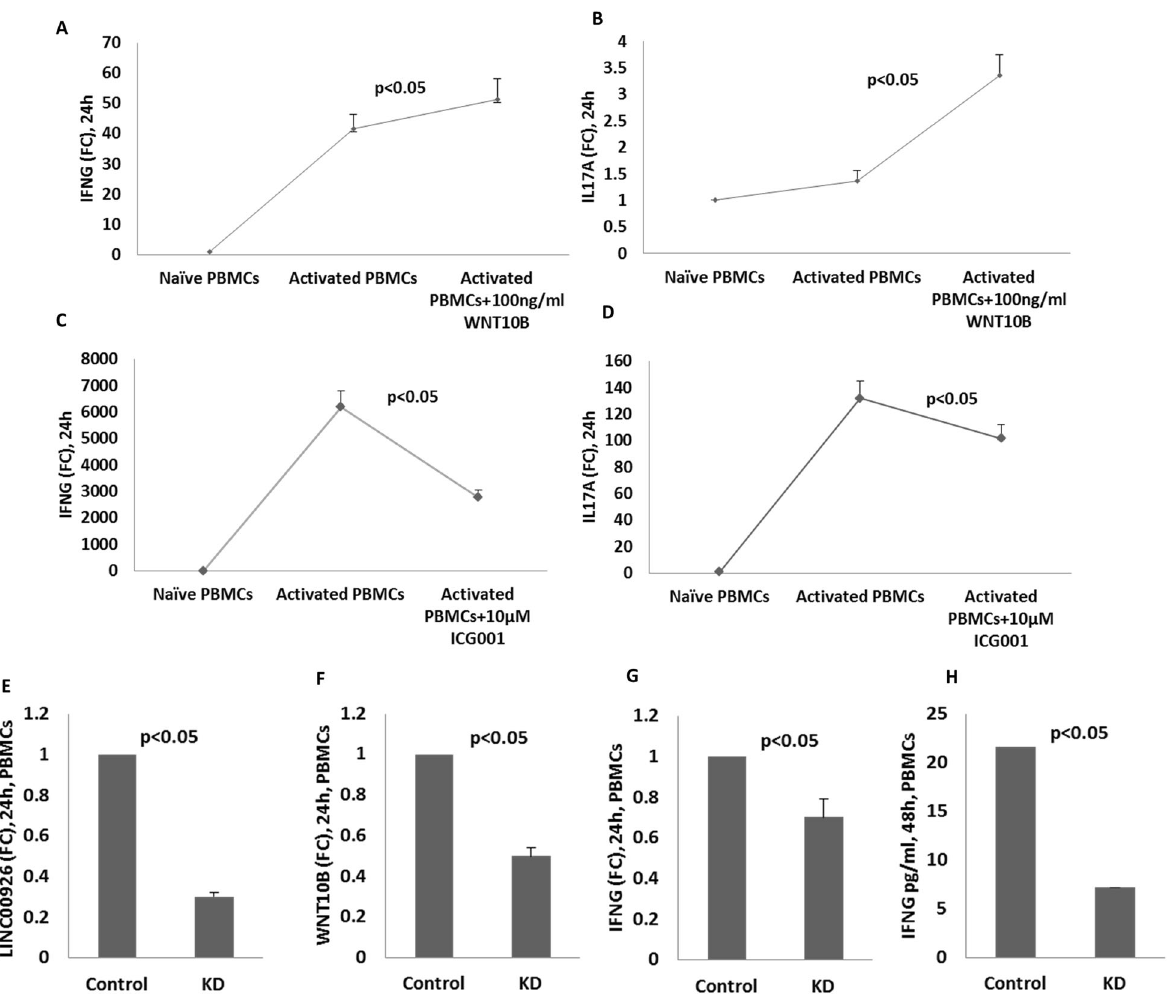
Fig. 4 Regulation of in fl ammatory gene expression by WNT10B. In order to evaluate the effect of increased WNT10B on the expression of in fl ammatory genes, pre-activated PBMCs were exposed to recombinant human WNT10B from outside. Levels of IFNG and IL17A transcripts were then measured after the indicated duration of culture. In another experiment, inhibitor (ICG001) of WNT signaling pathway was used to see whether WNT signaling was responsible for the increased expression of IFNG and IL17A. Next, in order to show that LINC00926 was responsible for the increased expression of IFNG, LINC00926 was knocked down in PBMCs and the levels of WNT10B and IFNG was measured by qRT-PCR. Effect of enhanced WNT10B signaling on IFNG and IL17A in pre-stimulated PBMCs ( A , B respectively) and upon inhibition of WNT signaling, on IFNG and IL17A as measured by qRT-PCR ( C , D respectively). Effect of LINC00926 knock down on WNT10B and IFNG expression as measured by qRT-PCR in PBMCs ( E – G ) and by ELISA of culture supernatant for IFNG ( H